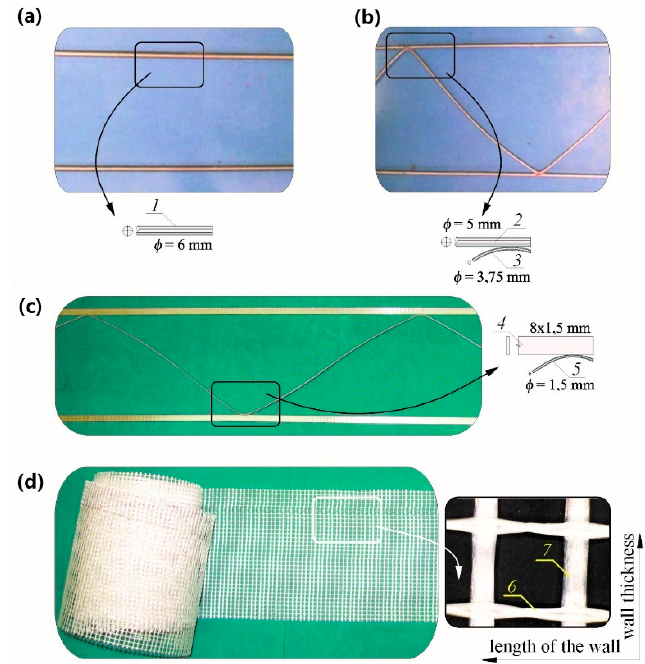
Figure 1. Reinforcements used in the tests: ( a , b ) reinforcement in solid brick walls and ( c , d ) reinforcementinawallmadeofCa-Siandautoclavedaeratedconcrete(AAC)masonryunits; 1—stainless steel bars, 2—truss strips made of bars with a diameter of 5 mm, 3—truss struts made of bars with a diameter of 3.75 mm, 4—truss strips made of 8 × 1.5 mm flat bars, 5—truss struts with a diameter of 1.5 mm, 6—weft fibres, and 7—warp